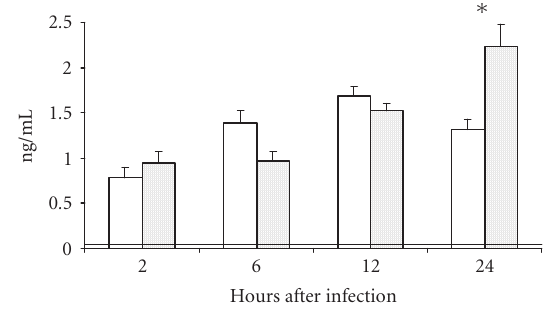
Figure 3: IL-10/TNF- α ratio in BALB/c mice protected with anti- LPS MAb Ru-O1 (gray bars) and unprotected mice (white bars) af- ter the IP infection with 50 CFU of K pneumoniae Caroli (O1 : K2) at di ff erent time